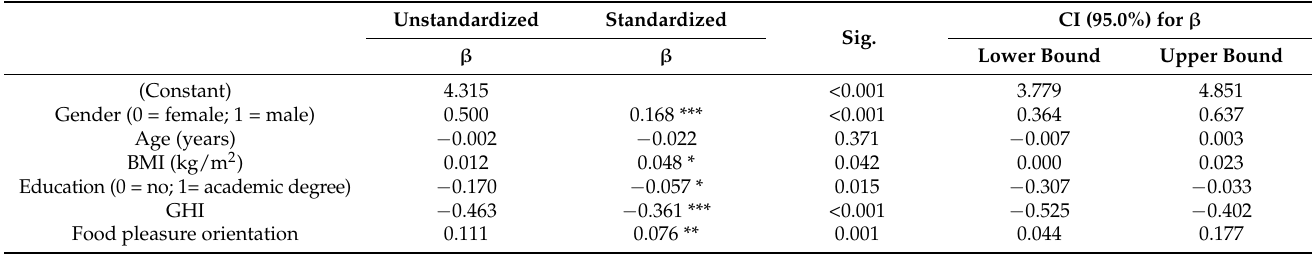
Table 1. The results of the linear regression. The prediction of unhealthy = tasty belief by the demo- graphic factors (gender, age, BMI, education) and attitudes (GHI, food pleasure orientation) ( n = 1537).